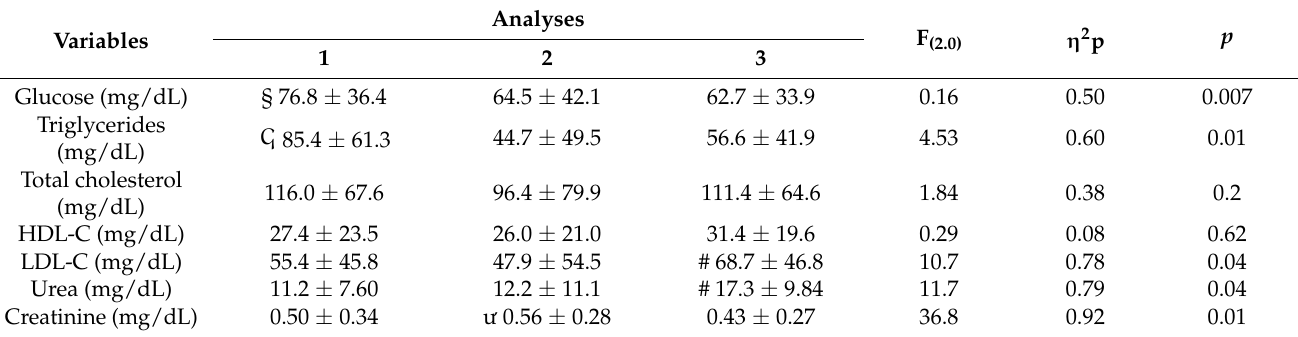
Table 3. Longitudinal effect of eating habits and guidelines for improving physical activity on biochemical parameters in children and adolescents with HIV.